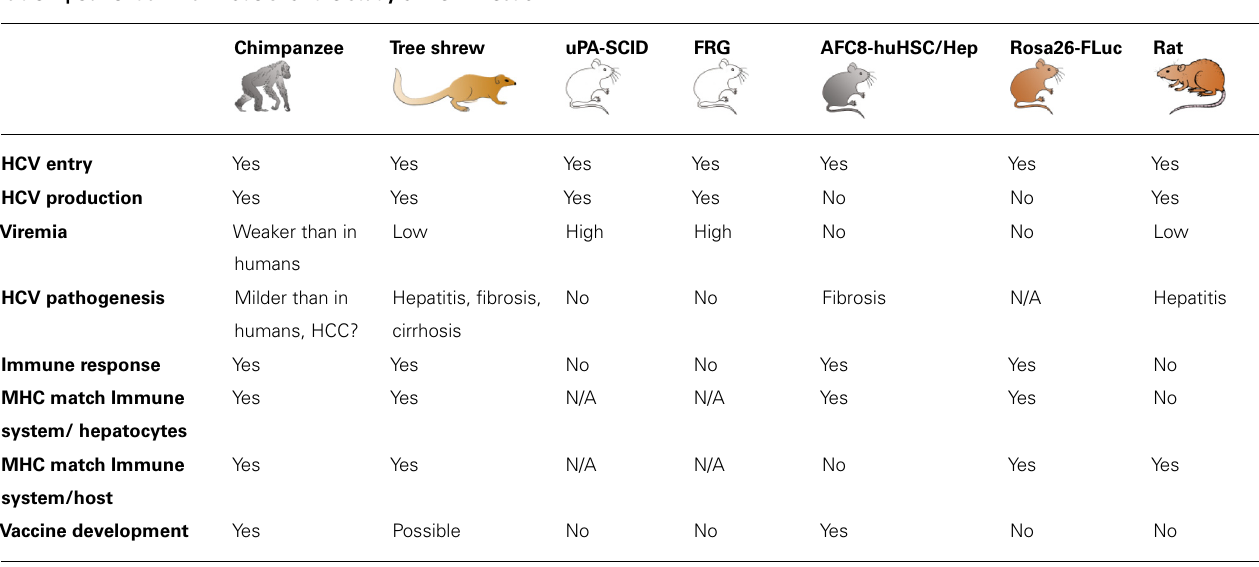
Table 1 | Current animal models for the study of HCV